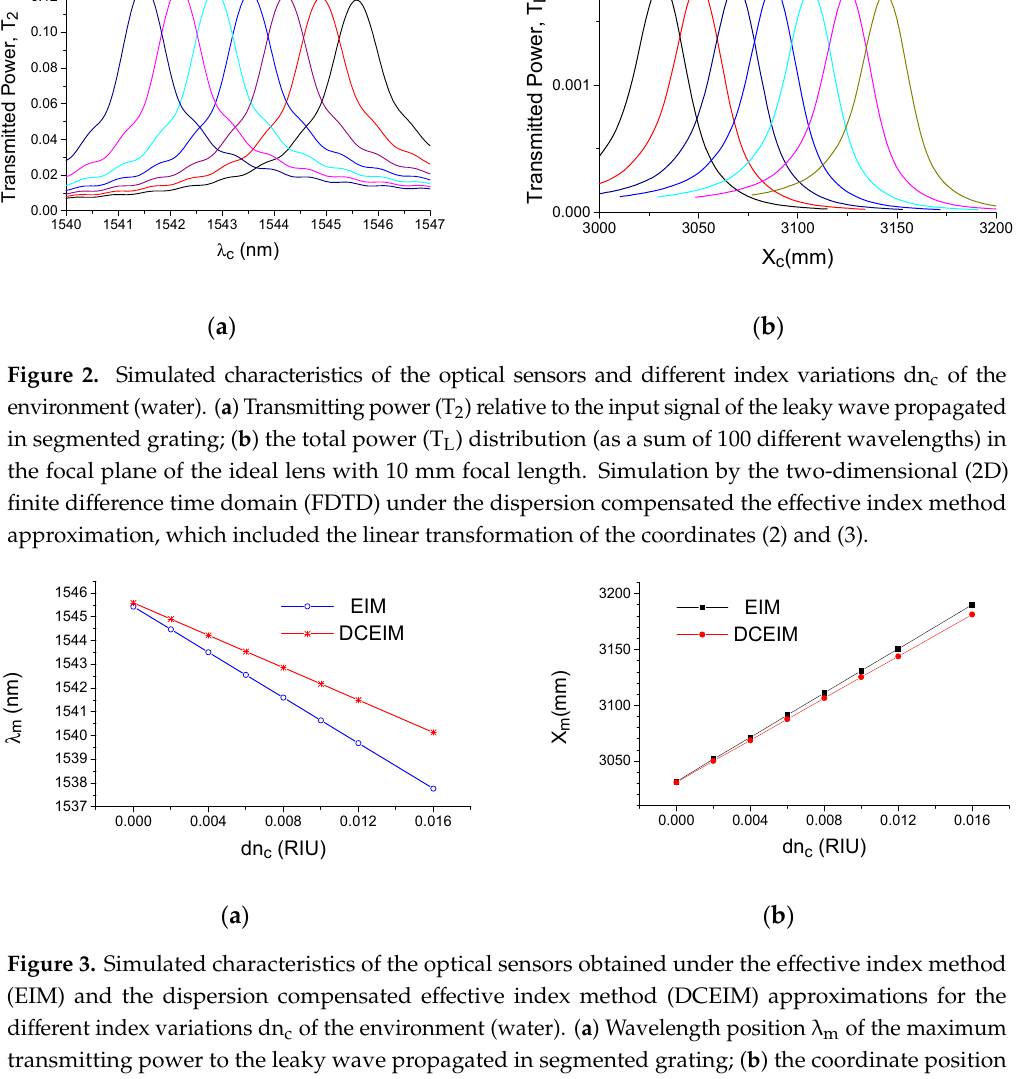
Figure 2. Simulated characteristics of the optical sensors and different index variations dn c of the environment (water). ( a ) Transmitting power (T 2 ) relative to the input signal of the leaky wave propagated in segmented grating; ( b ) the total power (T L ) distribution (as a sum of 100 different wavelengths) in the focal plane of the ideal lens with 10 mm focal length. Simulation by the two-dimensional (2D) finite difference time domain (FDTD) under the dispersion compensated the effective index method approximation, which included the linear transformation of the coordinates (2) and (3).